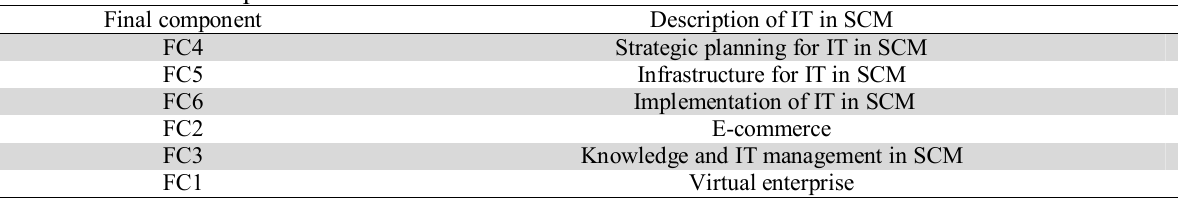
List of the final components